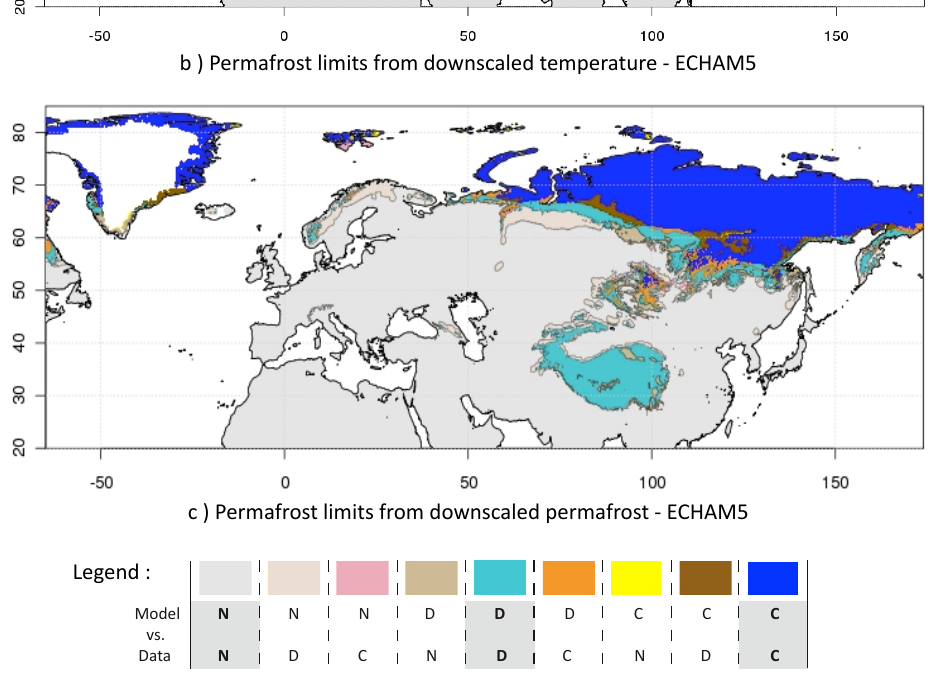
Fig. 3. CTRL permafrost comparison between ECHAM5 and the IPA/FGDC permafrost index. (a) Is obtained with a bilinear interpolation of temperatures and the RV conditions to derive permafrost. (b) Is the same from the downscaled temperatures by GAM. (c) Is the downscaled permafrost index by ML-GAM. In the legend panel,“N” corresponds to “No permafrost”, “D” to “Discontinuous permafrost” and “C” to “Continuous permafrost”. The highlighted categories with bold letters show the agreement between model and